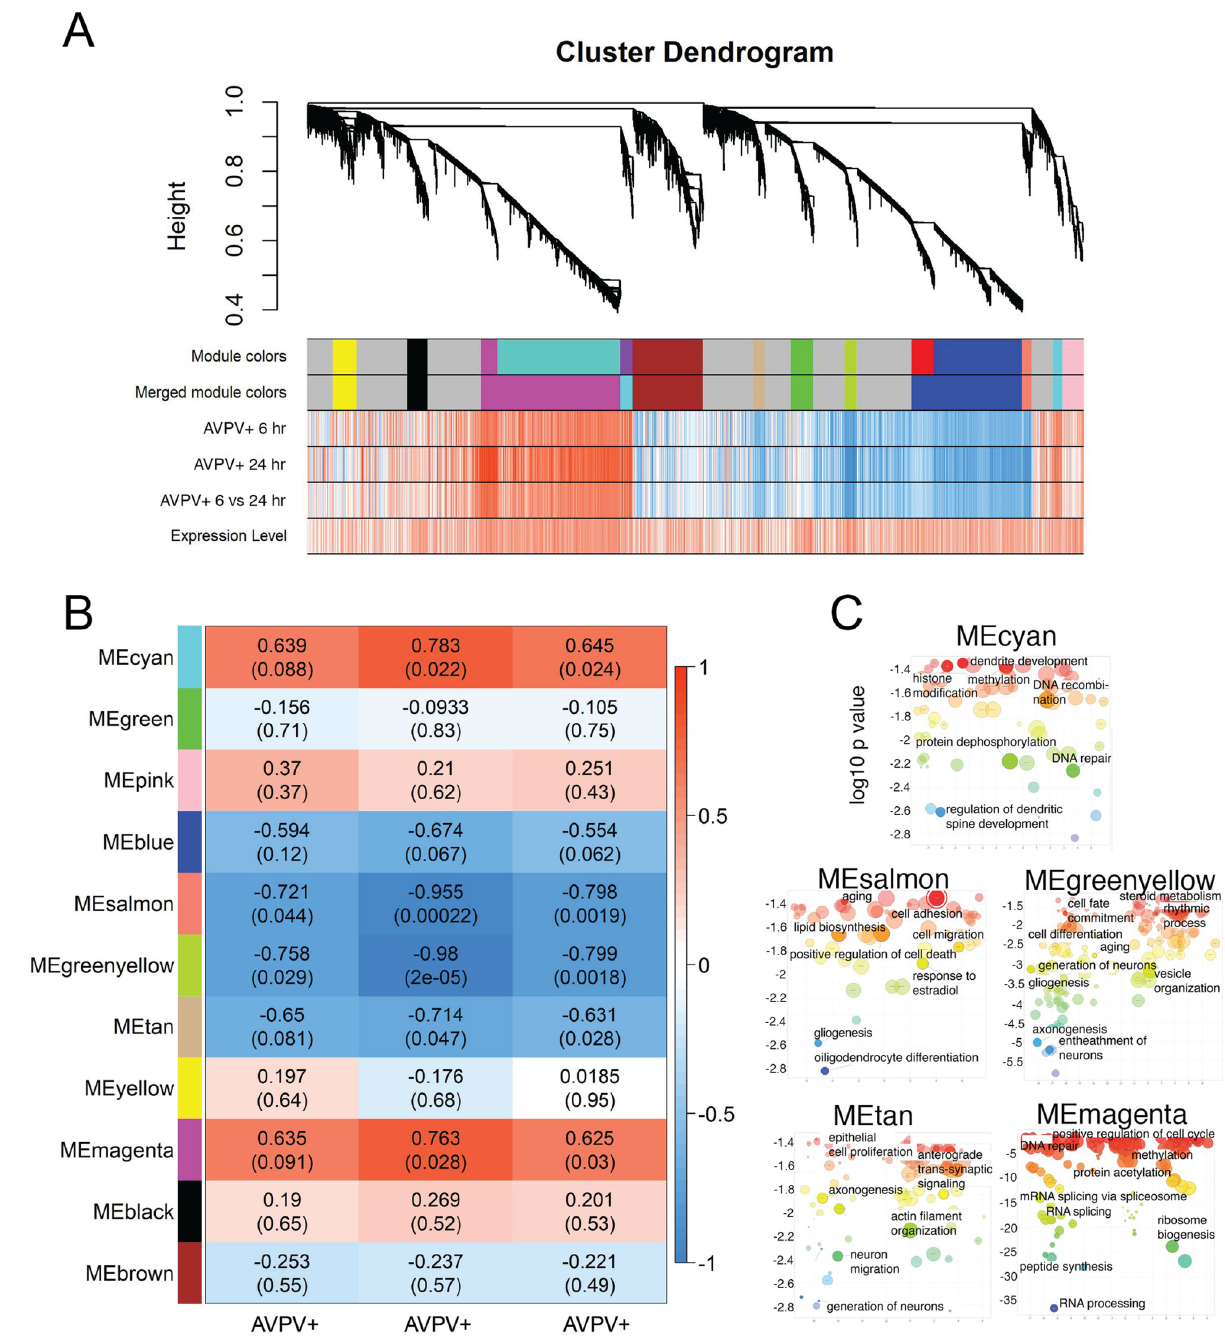
Fig 4. Gene network analysis: Clusters of genes modulated by EB in the AVPV+. (A) Cluster dendrogram demonstrating the hierarchical clustering of genes in the AVPV+ and heatmaps depicting the relative up- (red) and down-regulation (blue) of these genes by estradiol. (B) Heatmap showing Pearson correlation between gene coexpression modules defined by WGCNA in the AVPV+ and experimental conditions (6 hrs post-EB (compared to oil baseline), 24 hrs post-EB (compared to oil baseline) and 6 vs. 24 hrs post-EB). P values are indicated in parentheses. (C)GO-terms were visualized by log10 p-value (Y-axes) and Resnik (normalized) semantic similarity of GO-terms (X-axes).